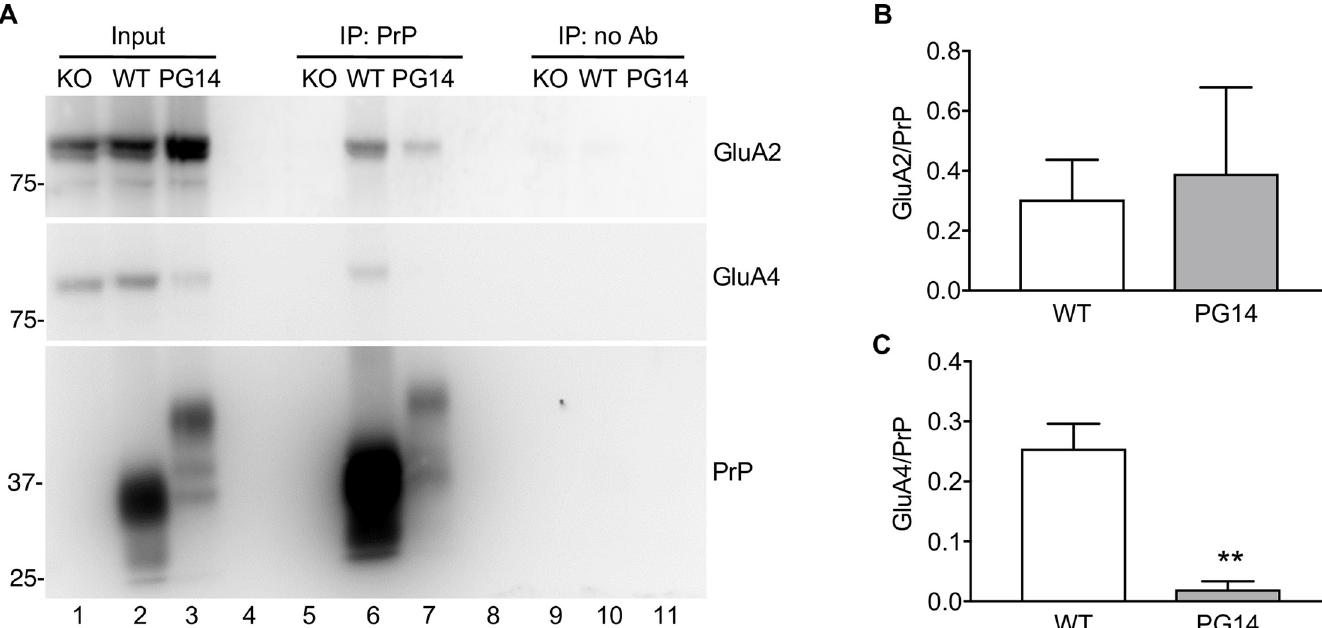
Fig 4. PrP and GluA2 co-immunoprecipitate from cerebellar extracts. (A) Cerebellar protein extracts (500 μ g) from Tg(WT), Tg(PG14) and PrP knockout (KO) mice were incubated with uncoated magnetic beads (IP: no Ab) or magnetic beads coated with anti-PrP monoclonal antibody 94B4 (IP: PrP). The immunoprecipitated proteins were analyzed by western blot with anti-GluA2 or anti-GluA4 antibody or anti-PrP polyclonal antibody P45-66. The input is 20 μ g of total proteins. (B, C) The amounts of immunoprecipitated GluA2 (B) and GluA4 (C) were quantified by densitometry of western blots like in (A) and normalized on the amount of immunoprecipitated PrP. Data are the mean ± SEM of 3–4 replicates from three independent experiments; �� p < 0.01 by Student’s t-test.